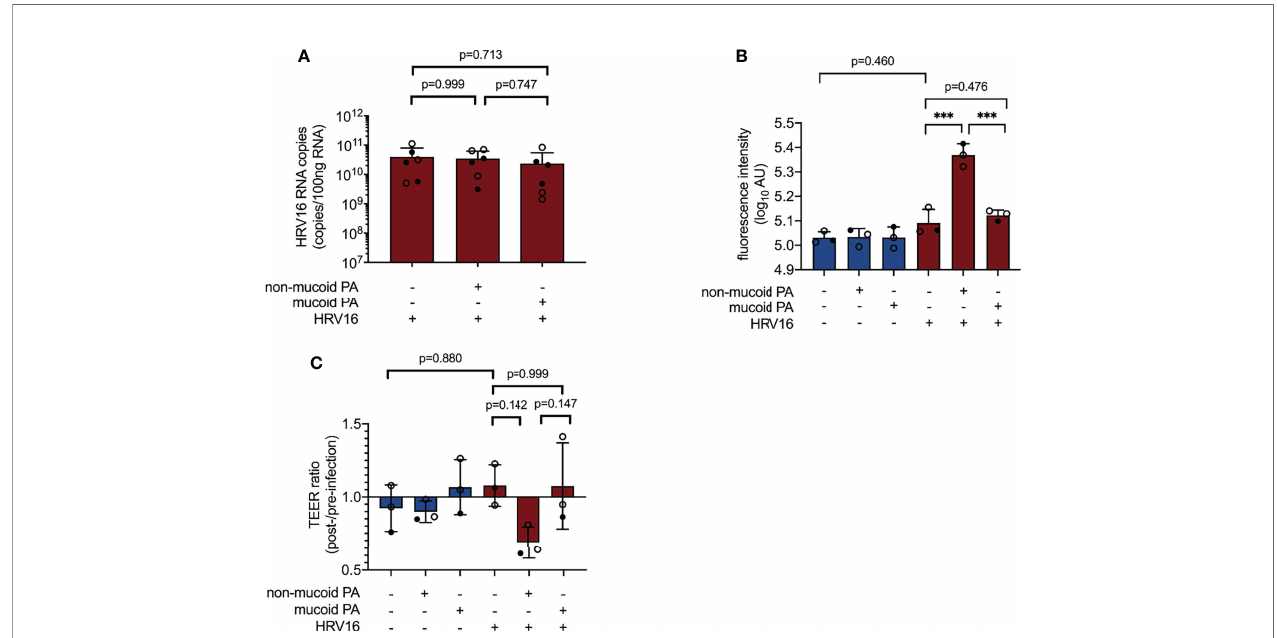
FIGURE 4 | Impact of PA/HRV co-infection on viral load and epithelial barrier function. (A) Viral RNA load in cell lysates 48 h post infection (RT qPCR) (B) Permeability of cell layers to FITC-labeled dextran 48 h after (co-) infection (C) Ratio of transepithelial electrical resistance (TEER) prior to HRV infection and 48 h after HRV infection. AU, arbitrary unit, cell type: ○ Emphysema ● Cystic fi brosis. Data were obtained in six (A) and three (B, C) independent experiments, each performed with cells derived from a different donor. *p ≤ 0.05, **p ≤ 0.01, ***p ≤